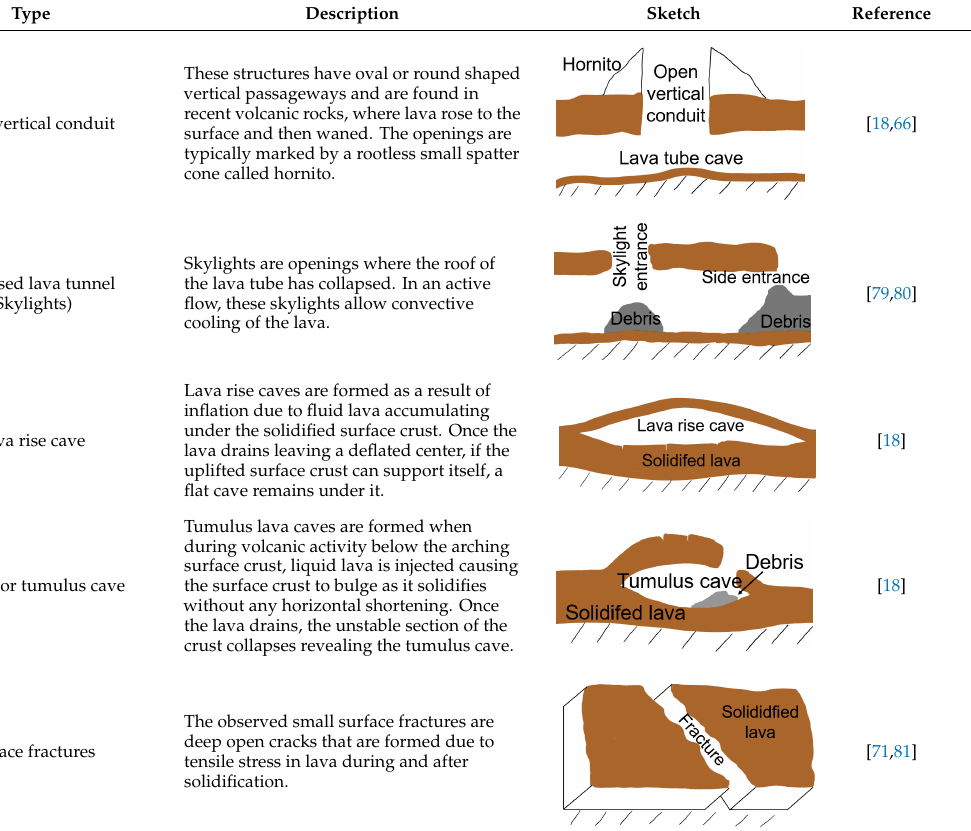
Table 4. Description of types of possible small cave openings observed in the study area.